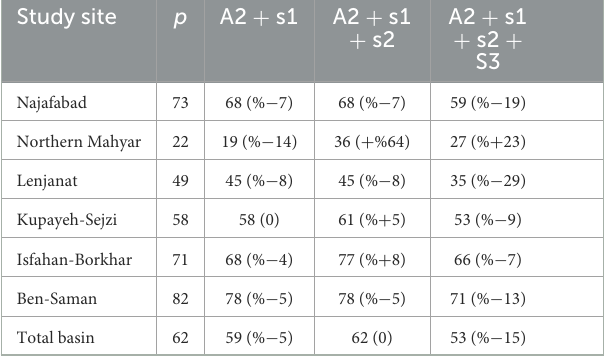
TABLE 6 The farmers’ gross return in different climate change scenario (million IRR/ha).